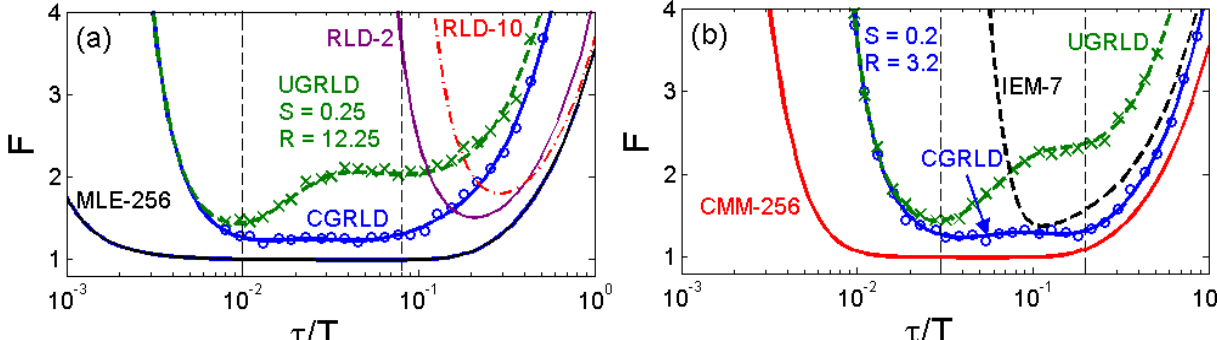
Figure 3. F -value versus τ / T plots of ( a ) previously reported 256 gate MLE, 2-gate RLD, 10-gate RLD (RLD-10), CGRLD/UGRLD with S = 0.25, R = 12.25, and ( b ) the proposed 256-gate CMM, 7-gate IEM, CGRLD/UGRLD with S = 0.2, R = 3.2. 3-D F -value plots of ( c ) R–S = 3 and ( d ) S =